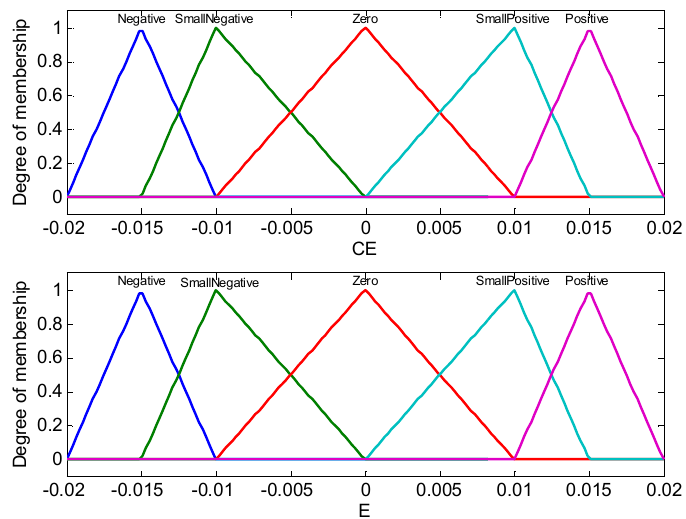
Figure 12. The output of the fuzzy inference system for ∆ K i .